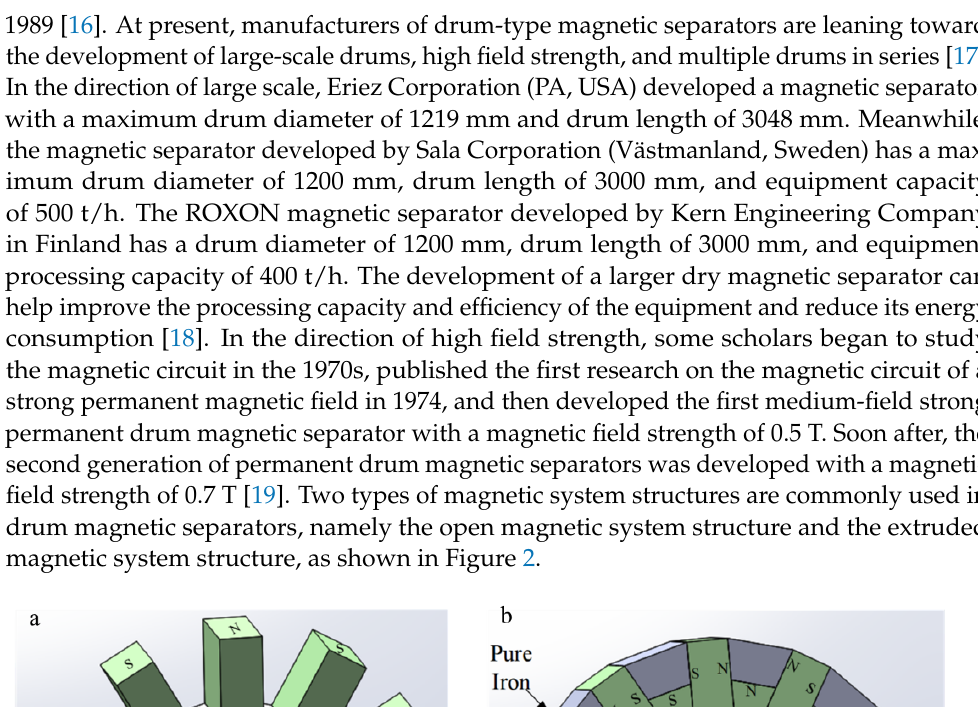
4 of 20 Figure 1. Schematic diagram of CT series magnetic pulley structure. 1—multipole magnetic system; 2—cylinder; 3—magnetic conductor; 4—belt [8]. 2.2. Dry Drum Magnetic Separator